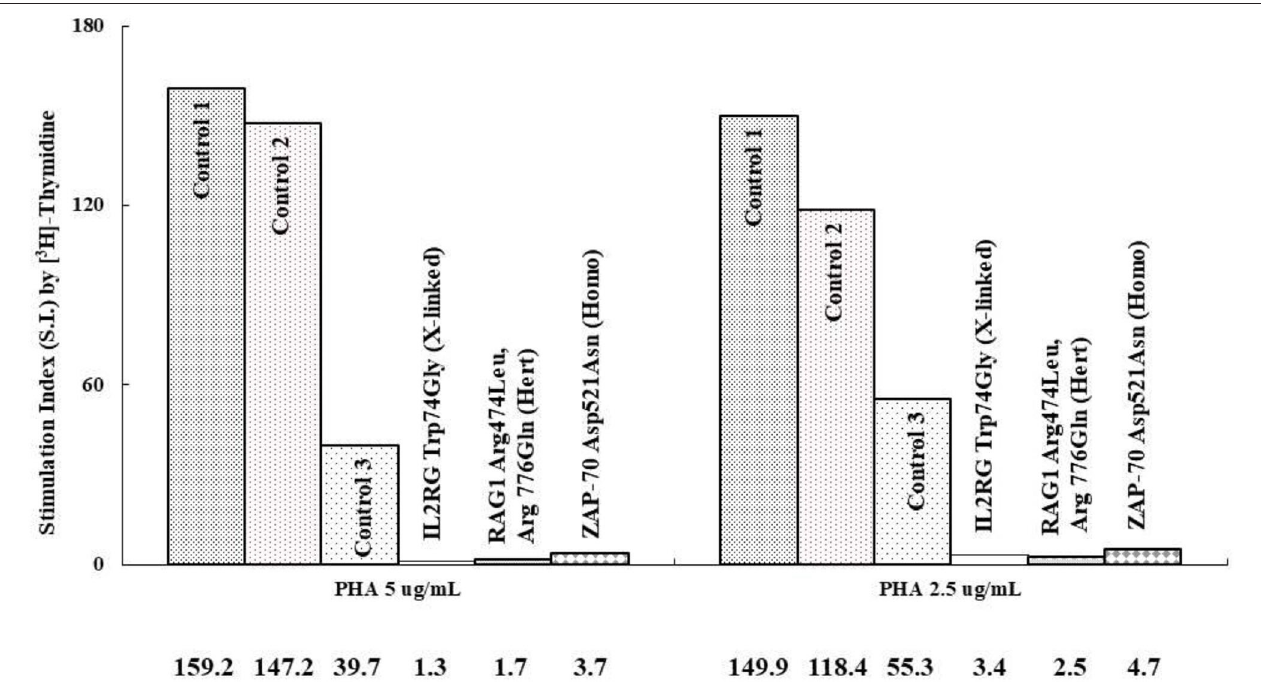
FIGURE 2 | We compared those with profound T cell immunodeficiency causing combined T and B immunodeficiency to the parallel controls (IL2RG mutation with 2.2% CD4, 0.3% CD8, and 38 mm 3 /CD3 vs. Control 1; RAG1 mutation with 3.2% CD4, 0.4% CD8, and 54 mm 3 /CD3 vs. Control 2, and ZAP70 mutation with 46% CD4, 5% CD8, and 1,645 mm 3 /CD3 vs. Control 3) at different time periods. The stimulation index (SI) (stimulated/blank [ 3 H]-thymidine incorporation) is shown in the region-axis labels.